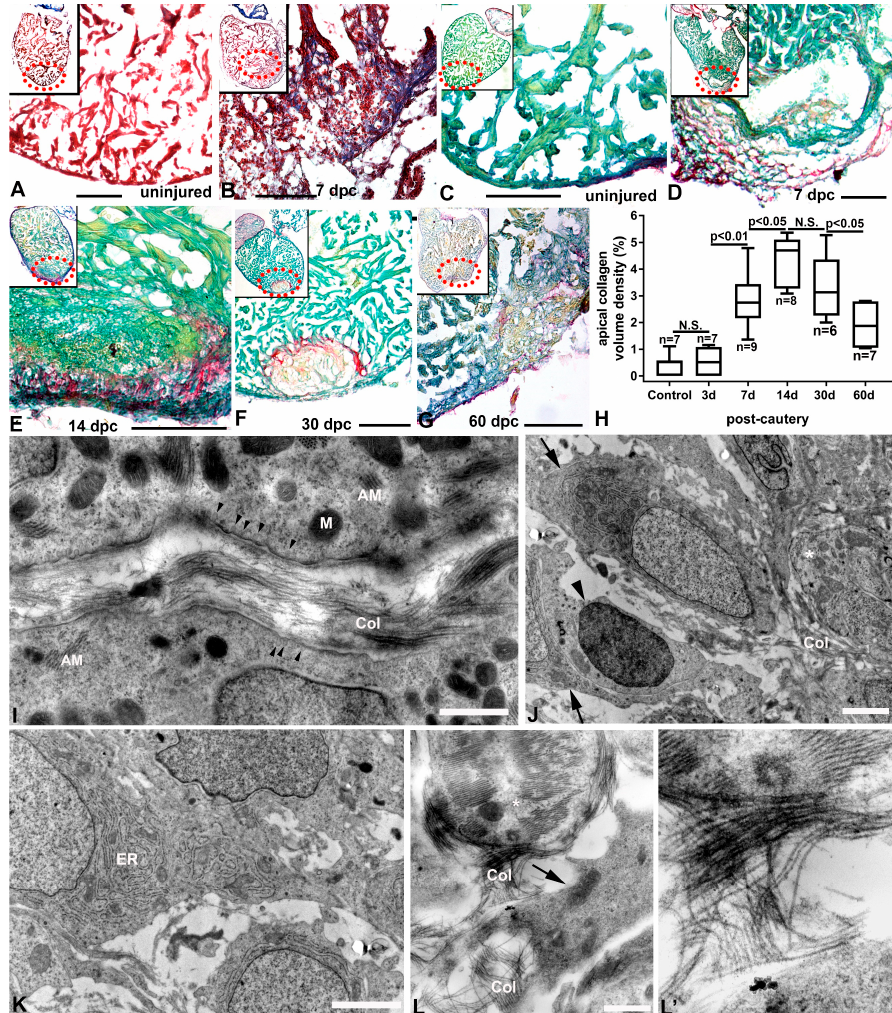
Figure 5. Collagen accumulation in the cauterized zebrafish ventricle. ( A ) Trichrome-stained section of an uninjured ventricle showing little collagen. ( B ) Section of the apical region of a heart at 7 days post-cautery (dpc) with marked accumulation of collagen (blue) in the injured and border zone region. Biebrich Scarlet stained the necrotic region (lower region on the panel) and truncated trabecular myocytes (upper part of the panel); inset shows the extent of the injury and the regional collagen accumulation. ( C – G ) Fast Green- and Sirius Red-stained sections in uninjured and cauterized hearts, showing accumulation and resorption of collagen (red) interspersed with remodeled cellular material (green) in the previously necrotic region. Magnified areas shown are from areas within dashed ellipses in upper left insets. ( H ) Quantification of collagen from control to 60 days post-cautery injury. ( I ) TEM of the injury border zone at 14 dpc, showing thick bundles of filamentous collagen fibers (Col) between trabecular myocytes of the compact and spongy heart (AM, actin–myosin bundles; M, mitochondrion; arrowhead, caveolae). ( J ) TEM of an injured and poorly organized compact (cortical) myocardium of a 14 dpc heart, showing loosely associated low sarcomere-containing cardiac myocyte (asterisk) and fibroblasts (arrows). An inflammatory cell (arrowhead) could be seen attached to a fibroblast. ( K ) TEM of activated fibroblasts in the same region showing extensive rough endoplasmic reticulum (ER) and collagen accumulation in the interstitial space. ( L ) TEM of the junctional region at 14 dpc with a thick bundle of collagen decorating the basal aspect of a trabeculated myocyte (asterisk) and a fibroblast (arrow). ( L (cid:48) ) Higher magnification micrograph showing a bundle of collagen in contact with the cardiac myocyte and the fibroblast. Scale bars: A – G = 100 µ m, I – L = 1 µ